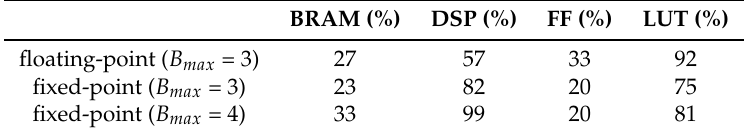
Table 1. Resource usage obtained from HLS for HI data set on Zedboard, bands =